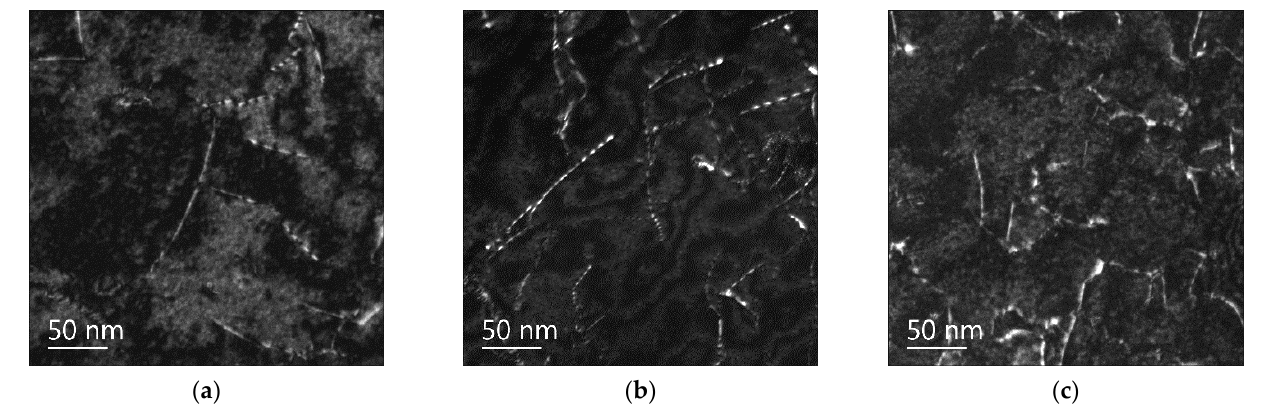
Figure 2. Dark- field TEM images of MM ( a ), HL ( b ) and HH ( c ) steels in the typical dislocation loops observation conditions after neutron irradiation at 400 °C up to 120 × 10 22 n/m 2 (no loops are present).